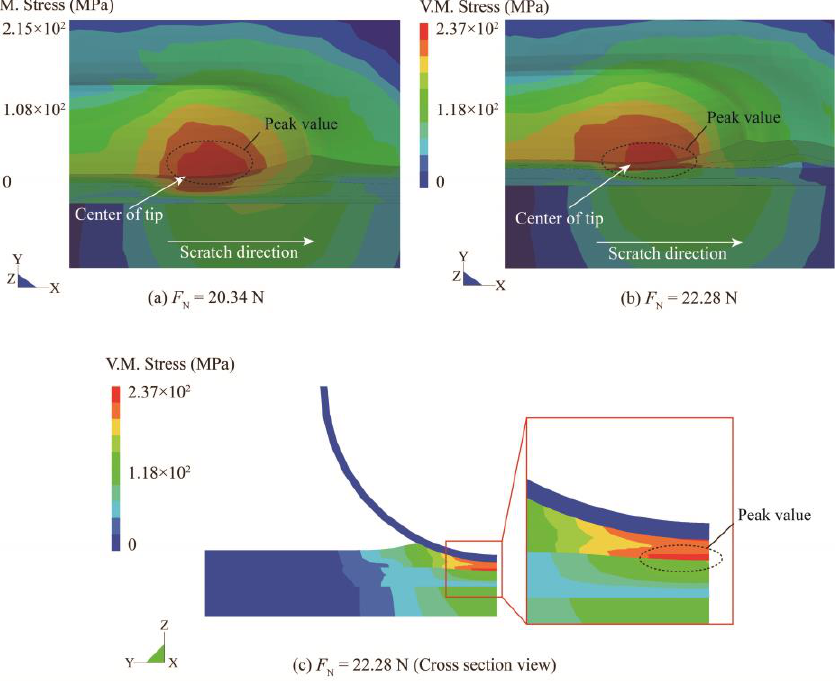
Figure 9. The von Mises stress contour beneath the scratch tip during scratching at the normal load of ( a ) delamination initiation; ( b , c ) plowing.